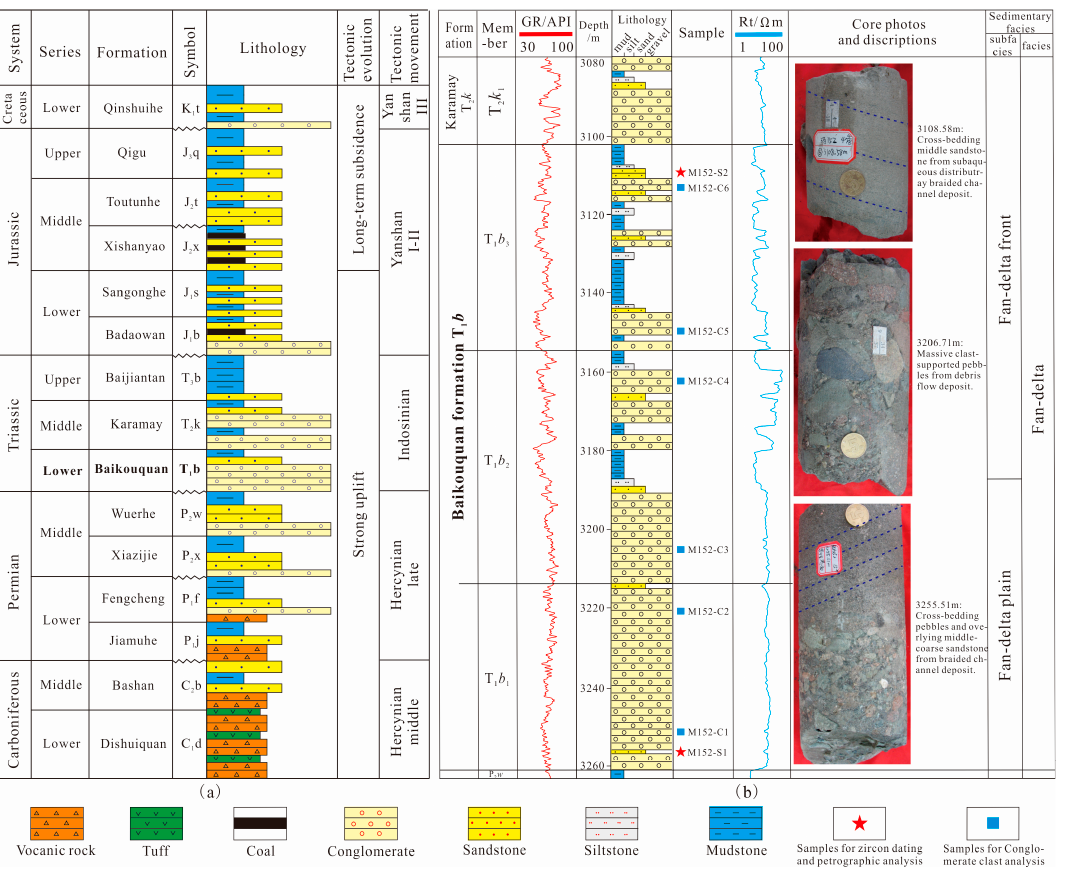
Figure 2. ( a ) Simplified stratigraphic column of Mahu Sag; ( b ) Stratigraphic column and sedimentary facies of Triassic Baikouquan Formation of Well M152, with the sample locations in this